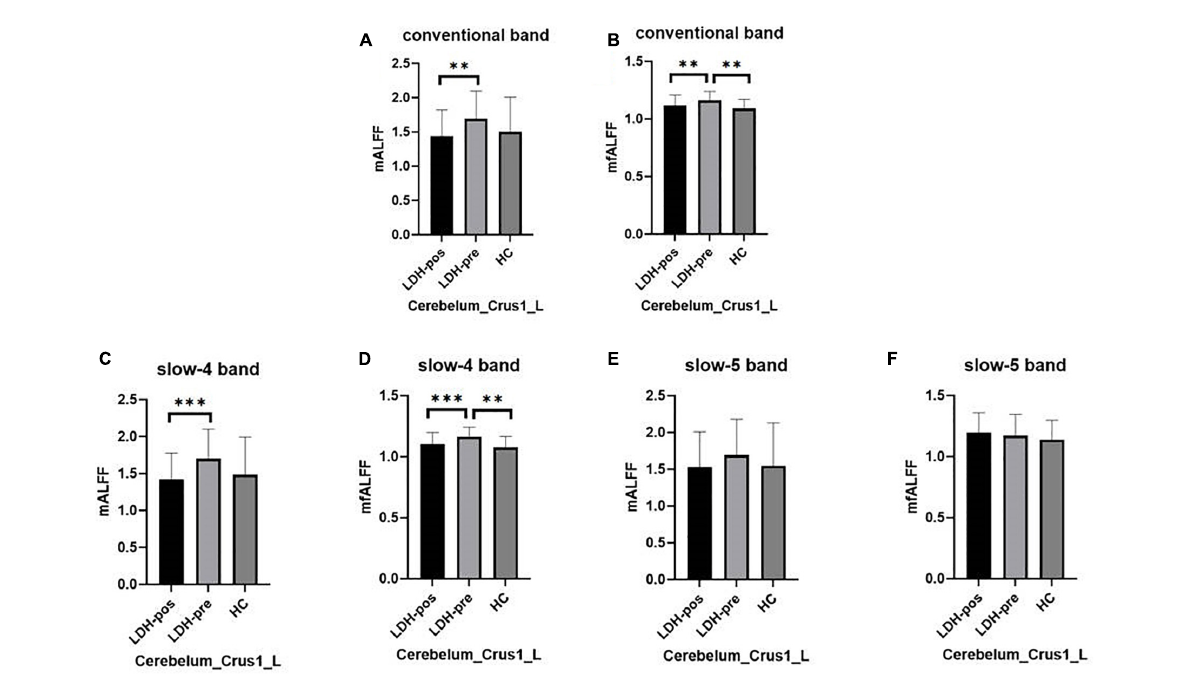
FIGURE5 The mean ALFF and fALFF values of signals extracted from left Cerebelum_Crus1 of each participant. The LDH patients and HCs were compared using two-sample t -tests, and LDH patients before and after SMT were compared by paired t -tests. ∗∗ Indicates significance level at p < 0.01 (two -tailed), ∗∗∗ Indicates significance level at p < 0.001 (two -tailed). (A,B) The mALFF value (A) and mfALFF value (B) in the conventional band from left Cerebelum_Crus1 of the HC, the patients with LDH before (LDH-pre) and after the SMT treatments (LDH-pos). (C,D) The mALFF value (C) and mfALFF value (D) in the slow-4 band from the from the same brain region of the three group. (E,F) The mALFF value (E) and mfALFF value (F) in the slow-5 band.